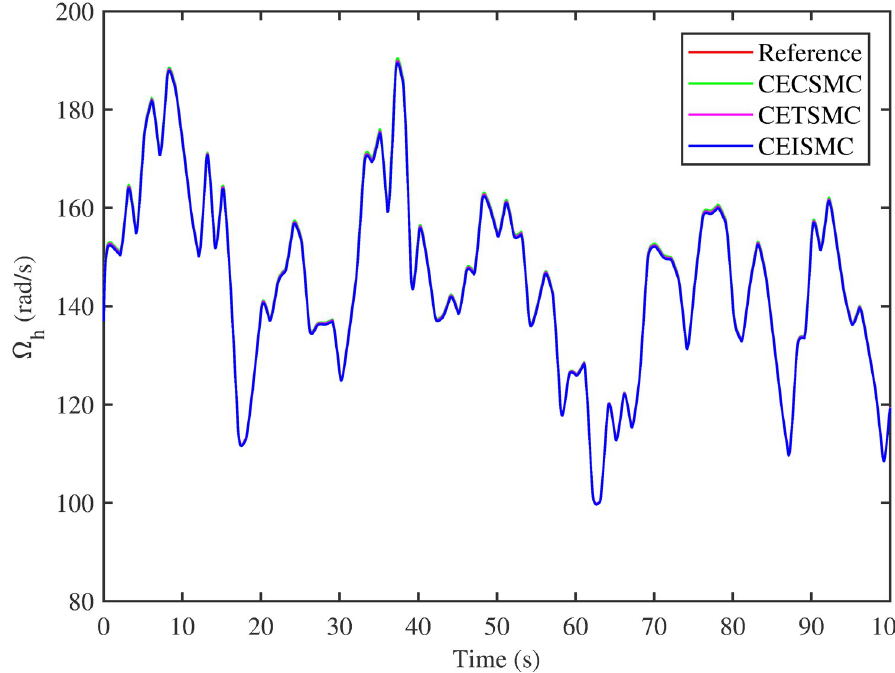
Fig 11. High speed shaft rotational speed.